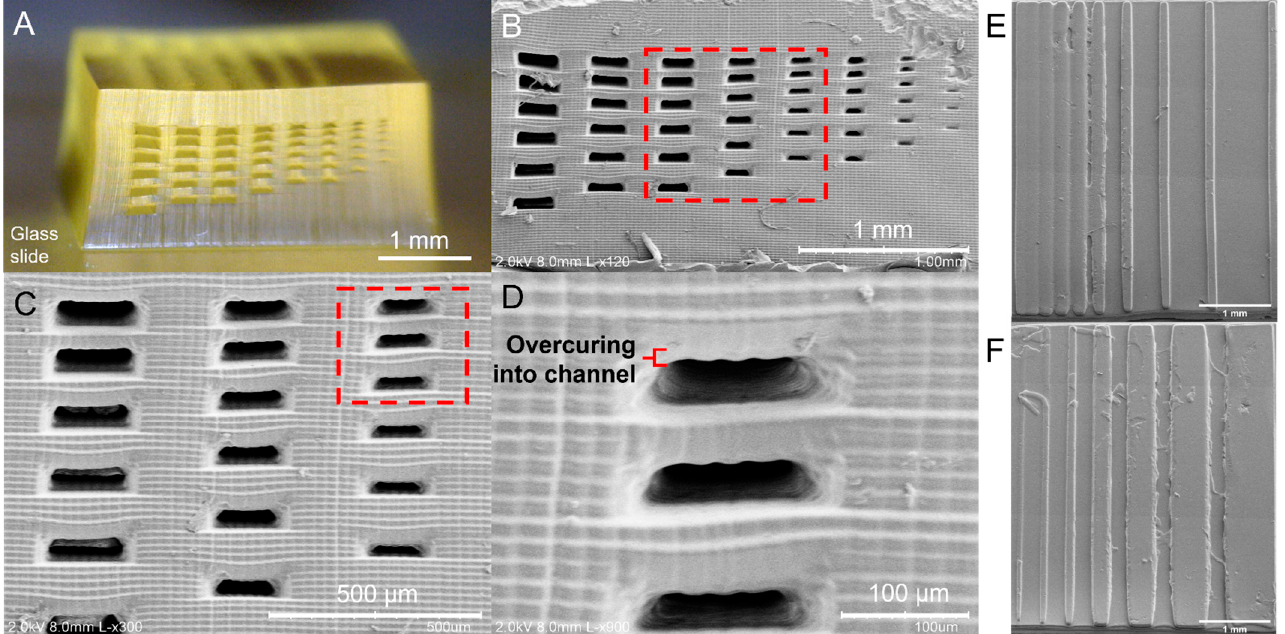
Figure 2. ( A ) Microfluidic characterization print showing cleared channels. ( B – D ) Front-view SEM images of the highly resolved micron-scale channels. Red box in ( B ) highlights selected channels dimensioned for resolution performance. Summary available in Figure S2. Red box in ( C ) identifies zoomed-in region shown in ( D ). ( D ) Overcuring into the channel is evident and highlighted on the image with a red bracket. ( E , F ) XY pixel resolution parts with ( E ) constant pillar width and ( F ) constant spacing. Summary of XY resolution is provided in Figure S2.